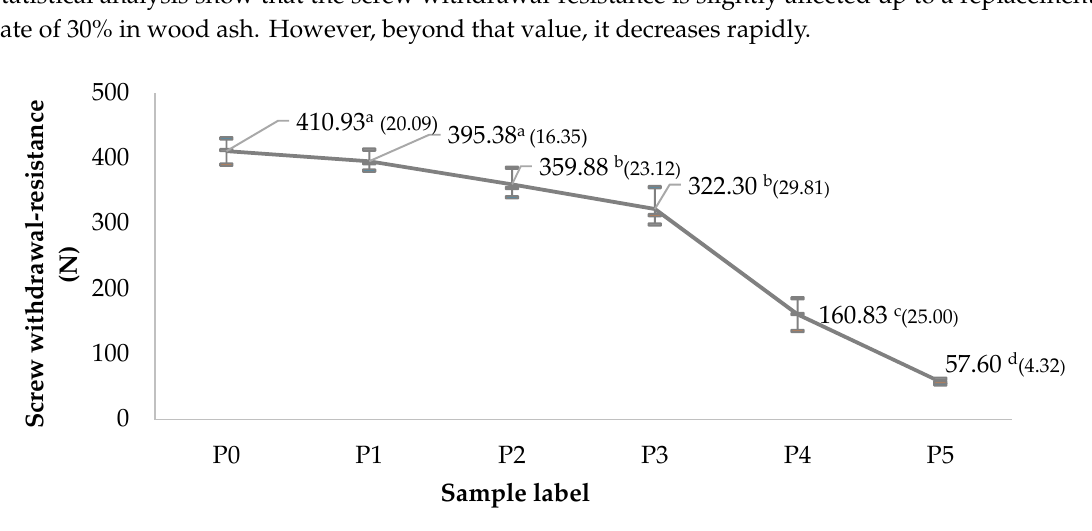
in in parentheses).